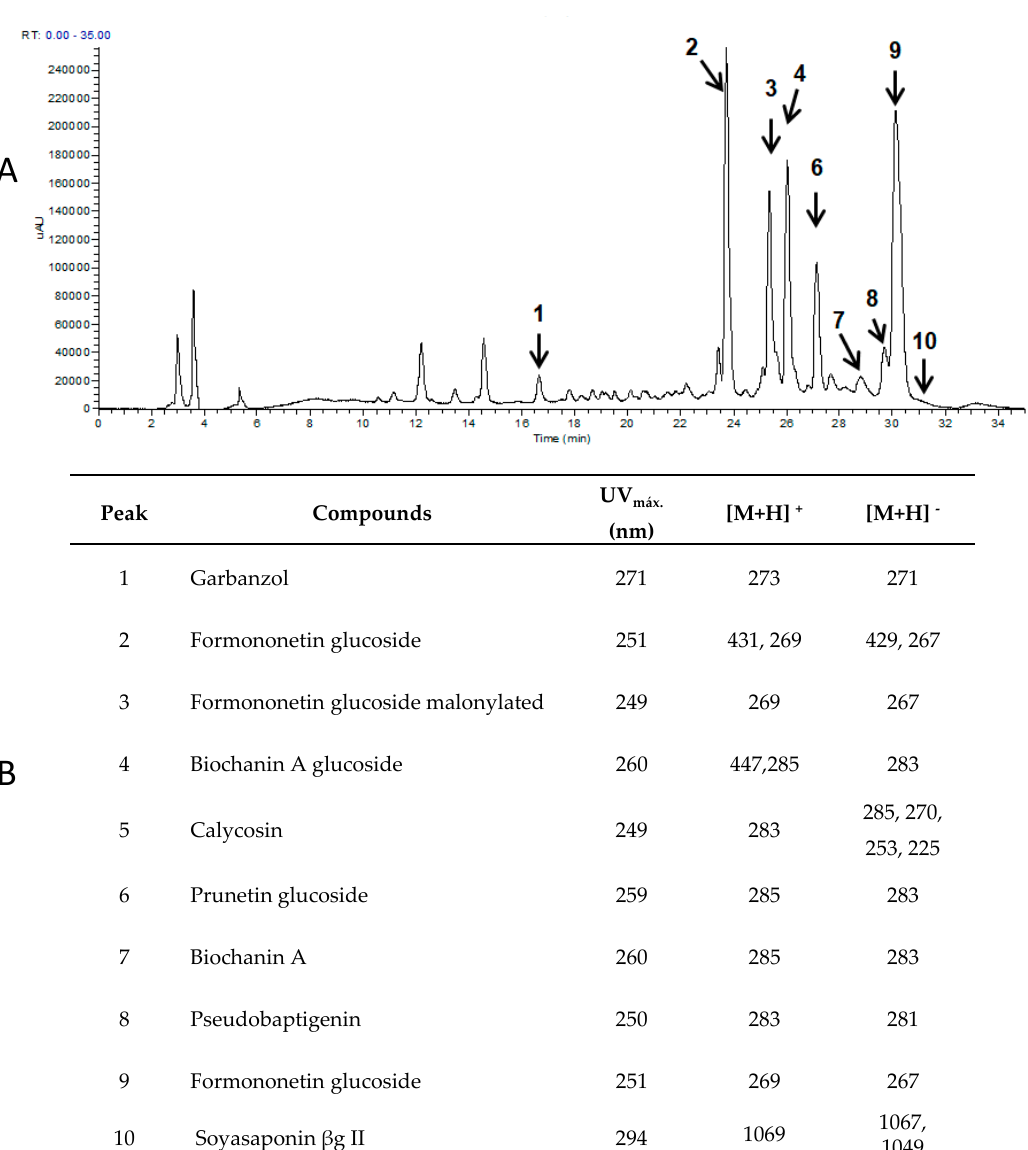
Figure 4. ( A ) chromatogram (260 nm) of iso-flavonoids from optimized chickpea sprouts (OCS) elicited with 30 mM H 2 O 2 and 72 h germination time. ( B ) Peak assignment of iso-flavonoids in OCS presented according to maximum UV absorption and molecular